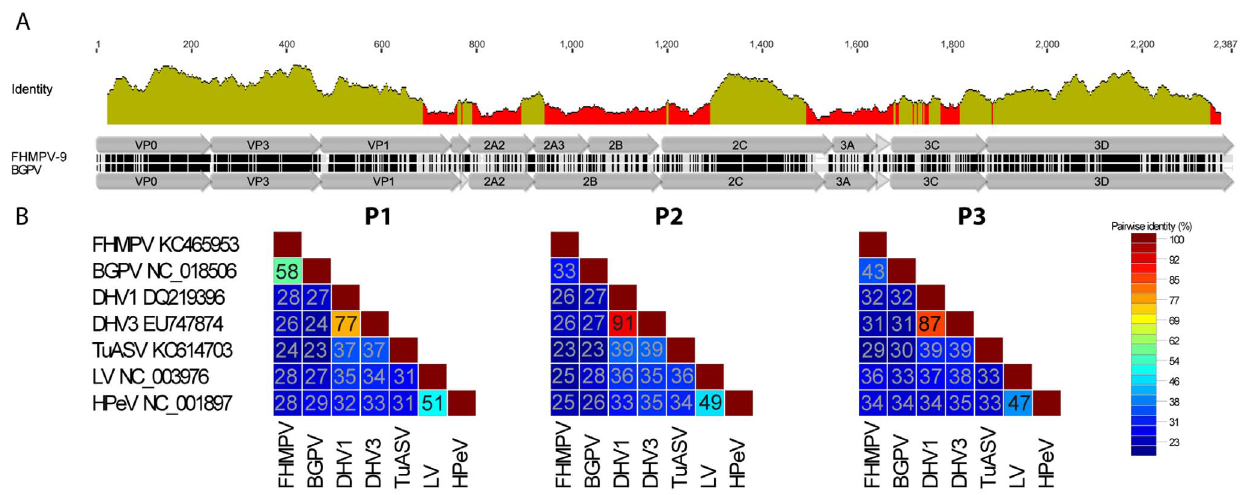
Figure 3. Fathead minnow picornavirus genome and diversity. Sequence divergence of FHMPV with other picornaviruses. A) Sequence identity plot comparing the complete polyprotein of FHMPV-09 and BGPV (YP_006628187.1), green represents amino acid identity between 30%– 100% and red represents identity less than 30%. B) Pairwise comparisons of closely related picornaviruses in the P1, P2 and P3 regions. Each number represents the pairwise amino acid identities between the corresponding species.